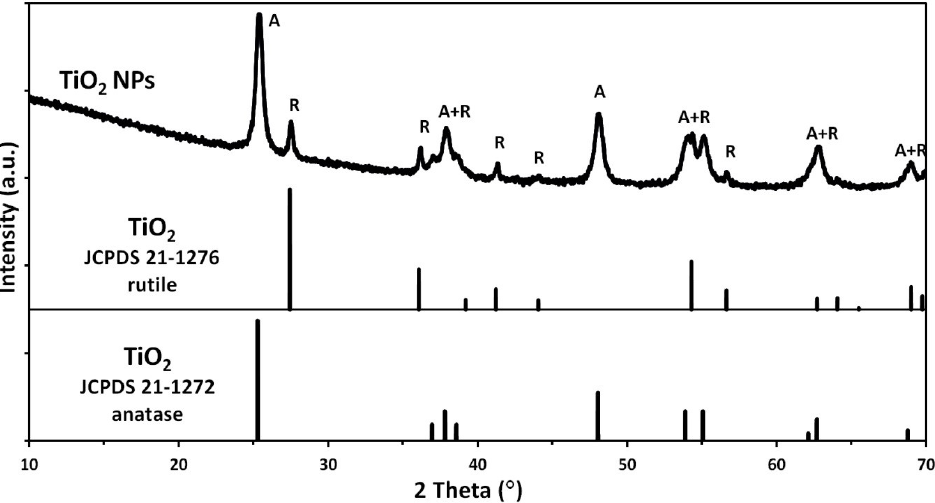
Figure 1. X-ray di ff raction pattern of TiO 2 nanoparticles (NPs). Figure 1. X-ray diffraction pattern of TiO 2 nanoparticles (NPs). Figure 1. X-ray diffraction pattern of TiO 2 nanoparticles (NPs).